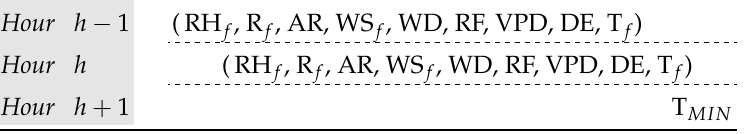
Table 4. Attributes that define a final instance in the dataset. This instance captures the temporal relationship between three consecutive hours.